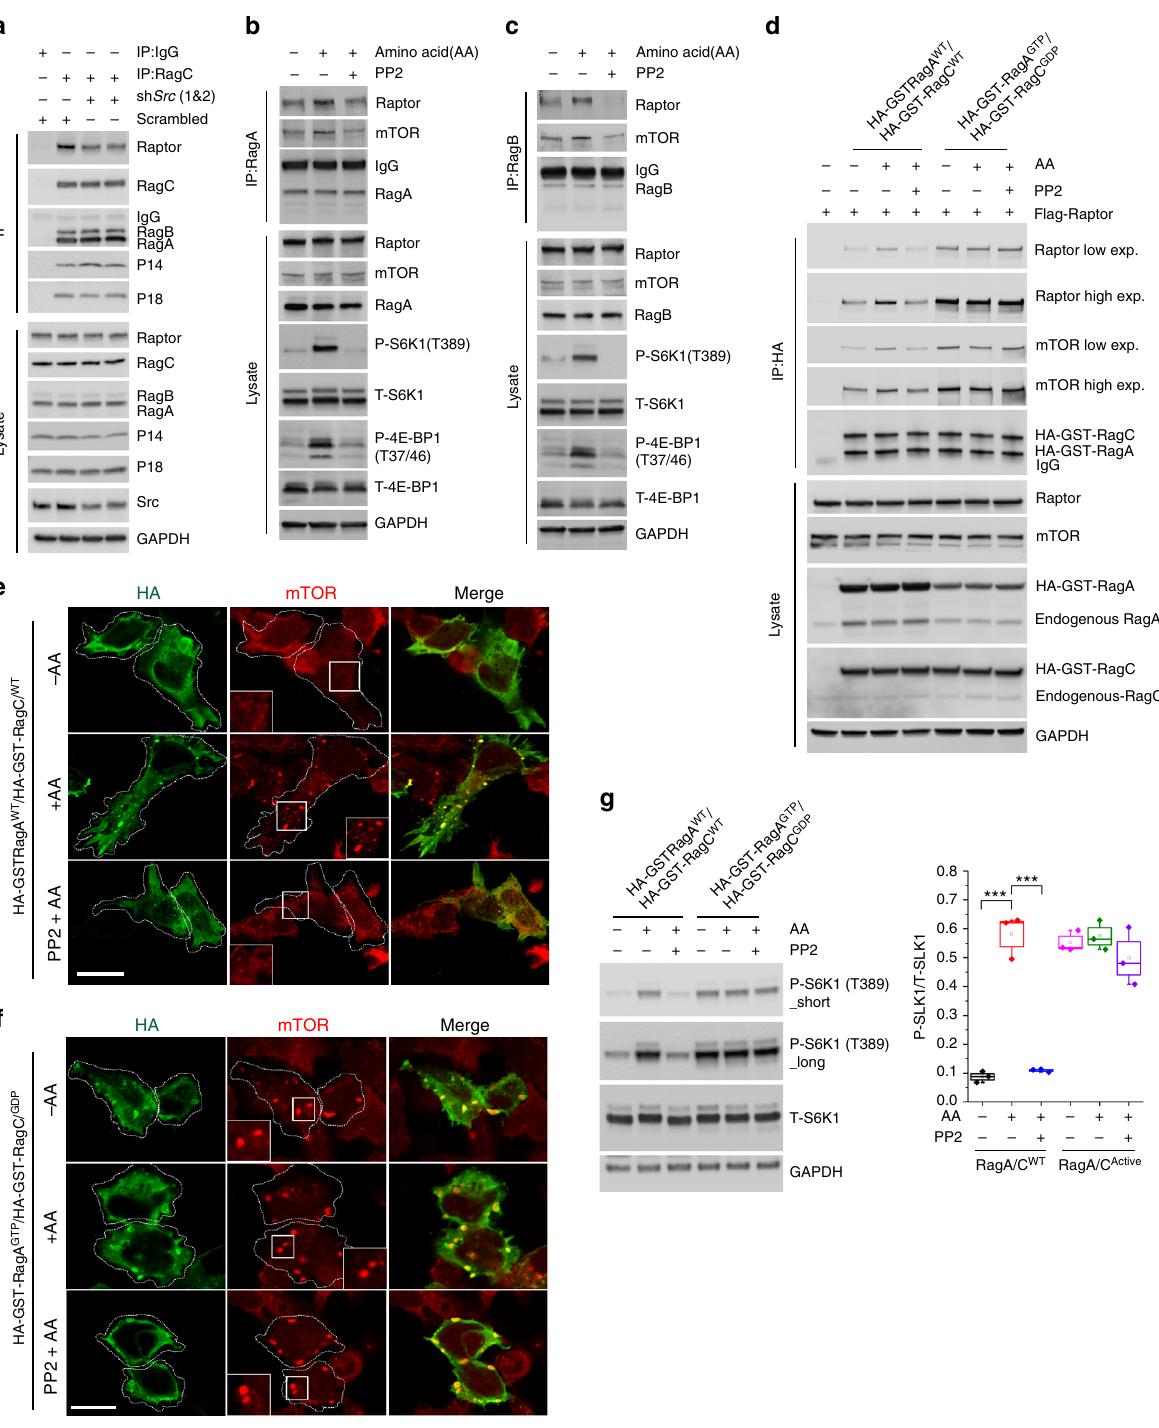
(Fig. 7). Src regulates localization and activation of mTORC1 upon amino acid stimulation, and Src activity per se is suf fi cient for the activation of mTORC1, irrespective of amino acid avail- ability. Our work also leads to a number of novel questions which will be interesting to explore in future studies. First, what is the upstream mechanism that activates Src in response to amino acids? Sestrin2 and CASTOR1 were characterized as sensors for cytosolic leucine and arginine, respectively 44 – 46 . Upon amino acid binding to sestrin2 or CASTOR1, GATOR2 dissociates from